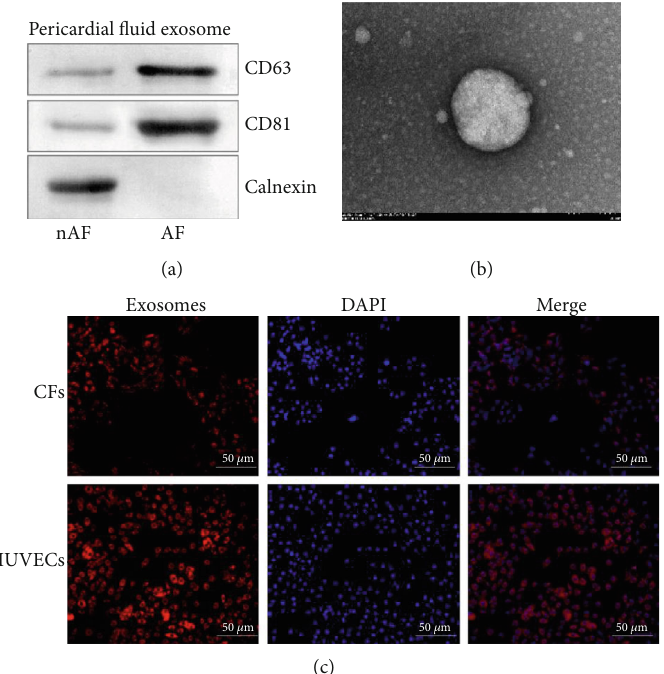
Figure 3: Characterization and the uptake of exosomes. (a) Biological markers of PF-derived exosomes were detected by western blot. (b) Images of exosomes acquired by TEM. (c) Uptake of PF-derived exosomes in CFs and